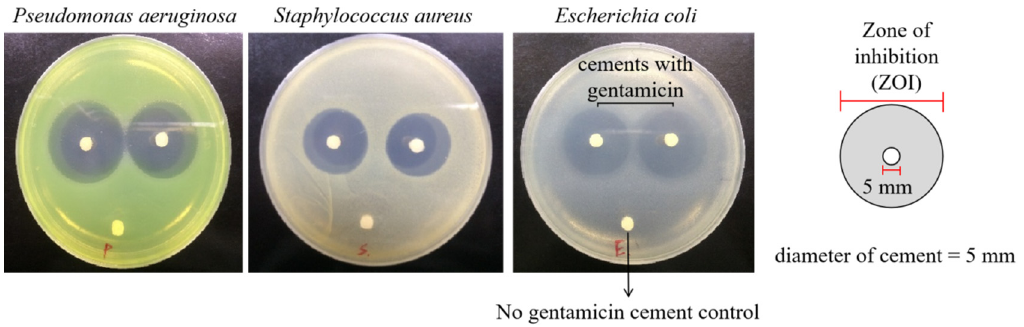
Figure 1. Representative photos of agar disk diffusion bioassay. ZOI of Pseudomonas aeruginosa , Staphylococcus aureus and Escherichia coli was measured as indicated in the illustration. The diameter of the bone cement disc was 5 mm.